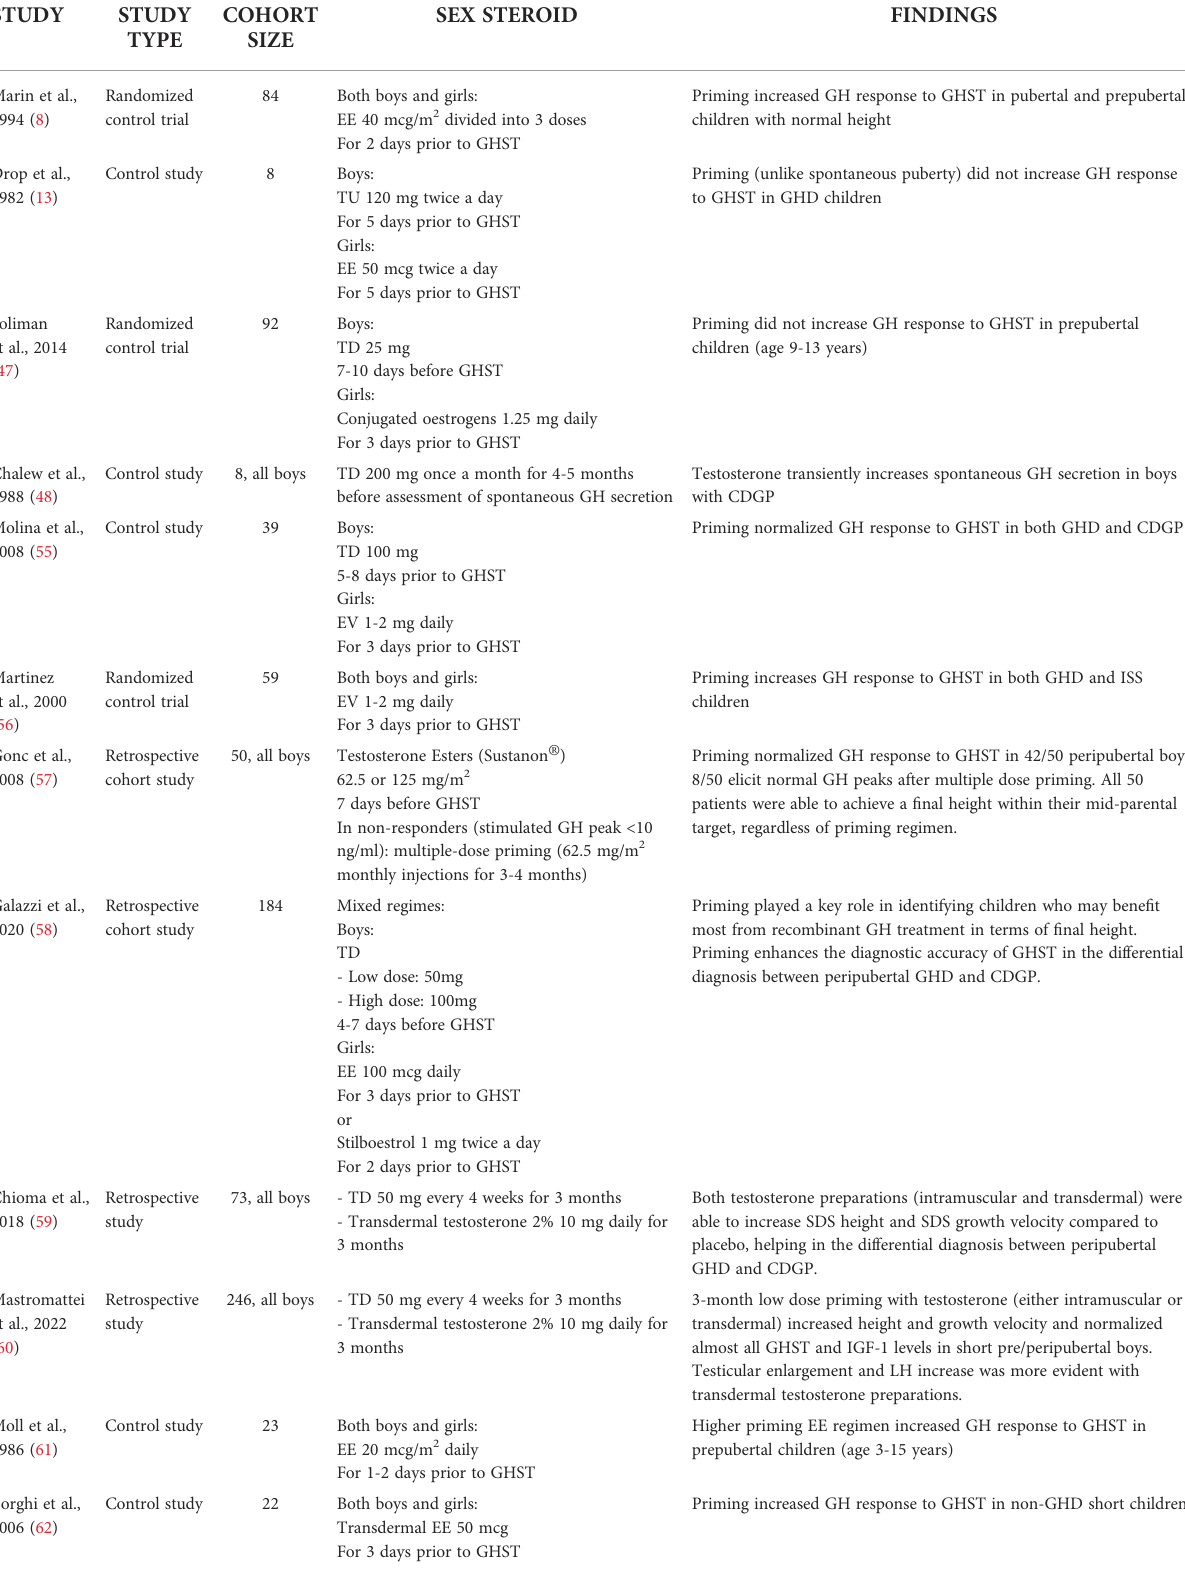
TABLE 1 Summary of the main clinical studies included in the